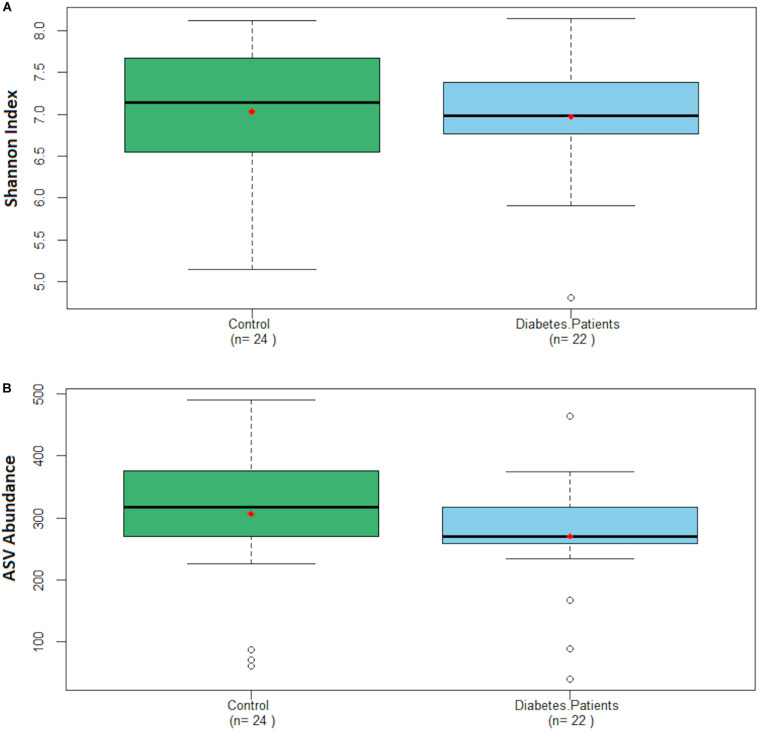
Boxplot charts depicting the distribution of the Shannon index (A) and ASV abundance (B) regarding both groups. Red dot represents the mean of each group.